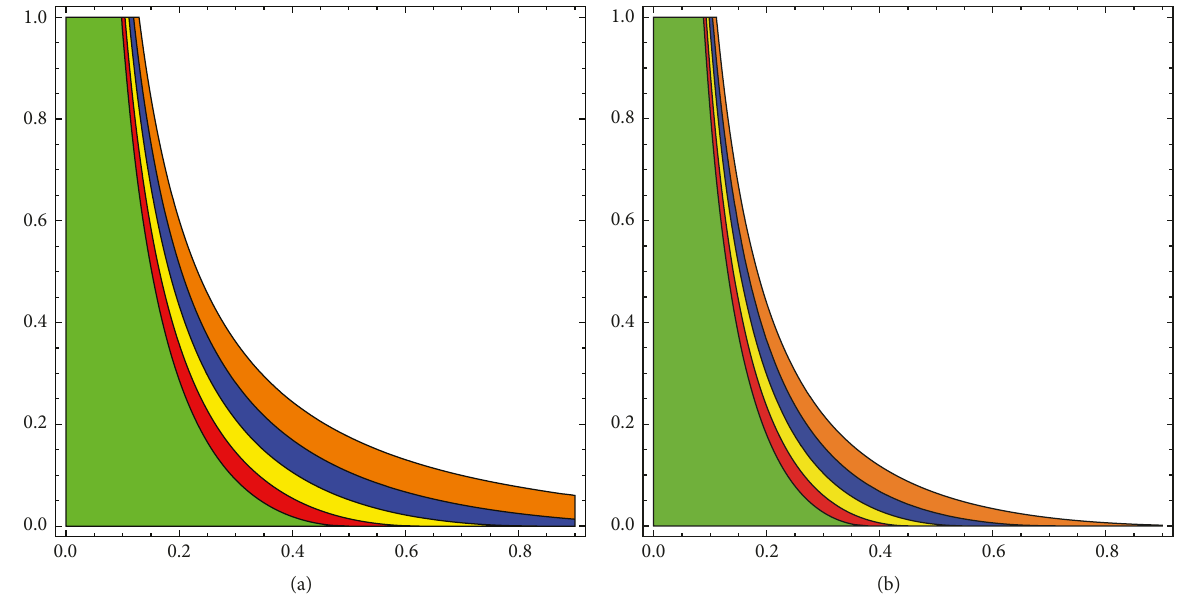
Figure 2: (a) Domain of parameters of (6) for 𝑄 = 0.4 . (b) Domain of parameters of (6) for 𝑄 = 1 ( 𝐾 1 = 0, 0.2, 0.4, 0.6, 0.8 represented by orange, blue, yellow, red, and green colors,